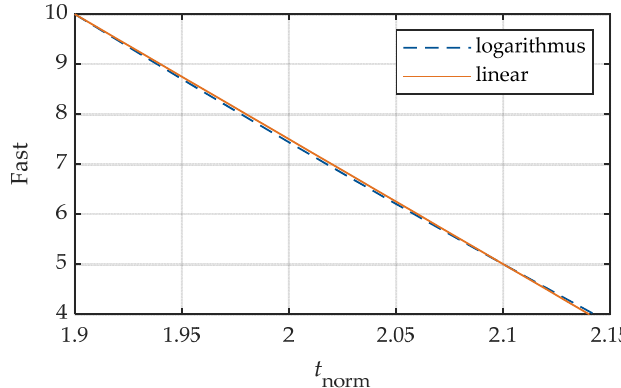
Figure 7. Scaling of the swiftness indicator.